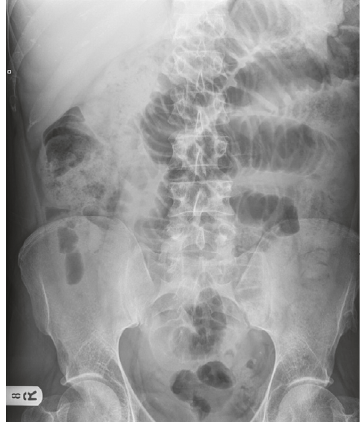
Figure 1: Abdominal plain film radiography demonstrating multi- ple dilated small bowel